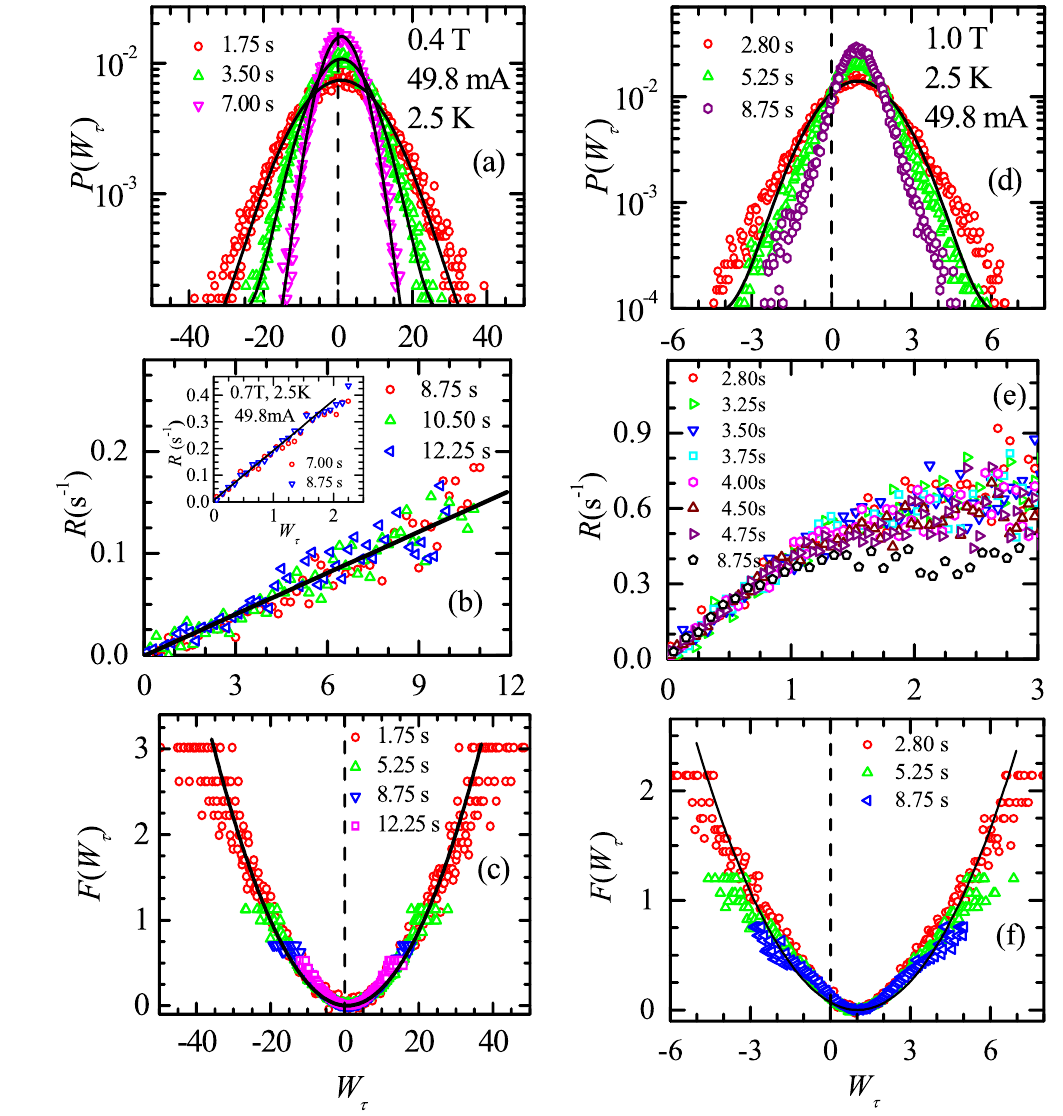
Figure 3. Validity of GC-NEFR and estimation of LDF. ( a ) Probability distribution P ( W τ ) vs W τ at 0.4 T, 2.5 K, and 49.8 mA for τ = 1.75, 3.50, and 7.00 s. The solid lines are fitted Gaussian’s. ( b ) R vs W τ (estimated from P ( W τ ) in Fig. 3a) for τ = 8.75, 10.50, and 12.25 s. Inset shows R ( W τ ) behavior for τ = 7.00 and 8.75 s at 0.7 T, 2.5 K, and 49.8 mA data. ( c ) The LDF, F ( W τ ) for τ = 1.75, 5.25, 8.75 and 12.25 s (estimated from P ( W τ ) in Fig. 3a). The solid line represents a quadratic fitting to F ( W τ ) data sets. ( d ) P ( W τ ) vs W τ , for τ = 2.80, 5.25 and 8.75 s at 1.0 T, 2.5 K and 49.8 mA. The solid line is a Gaussian fit to the data with τ = 2.80 s showing a clear deviation. ( e ) The R ( W τ ) behavior for different τ ’s. Clearly, the R ( W τ ) behavior is not linear. ( f ) The LDF for τ = 2.80, 5.25 and 8.75 s. The solid line is the quadratic fit to F ( W τ ) data sets (cf. text for details). The vertical dashed lines in ( a , c , d , f ) identify the W τ = 0